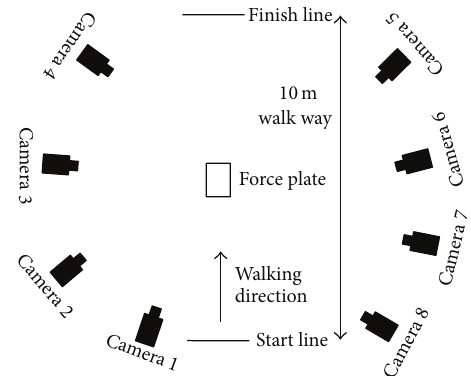
Figure 2: Schematic graph of the walking space and eight-camera system.